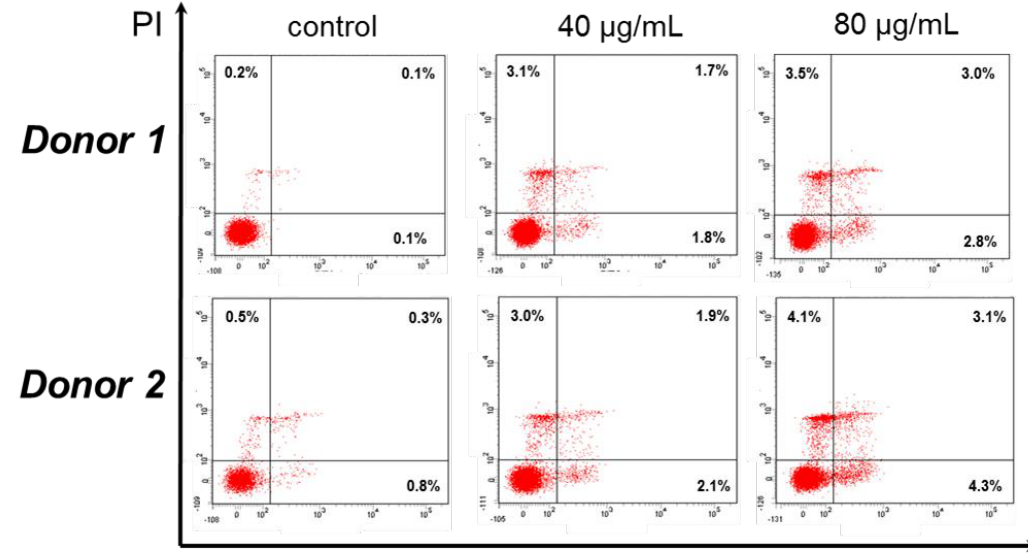
Figure 3. Compound 6 does not induce apoptosis or necrosis to peripheral blood mononuclear cells (PBMCs). PBMCs were isolated from 2 different donors (1 and 2) and incubated with 40 and 80 µ g/mL of compound 6 for 24 h. Other details as in Legend of Figure 2. Representative dot plots from both donors are shown from one experiment performed in duplicate.